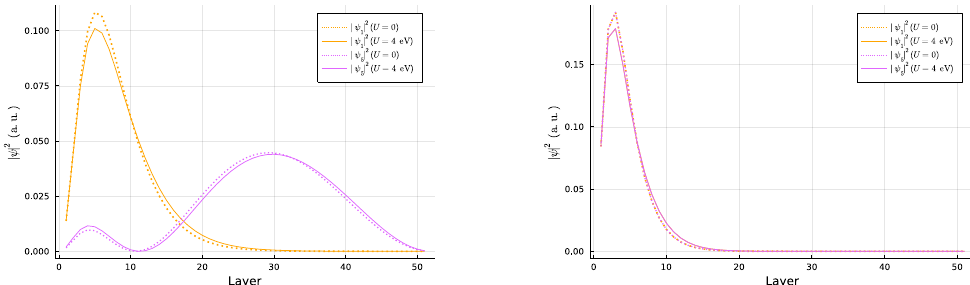
Figure A2. Spatial distribution of the eigenstates evaluated for (cid:126) k = 0, for benchmark choice